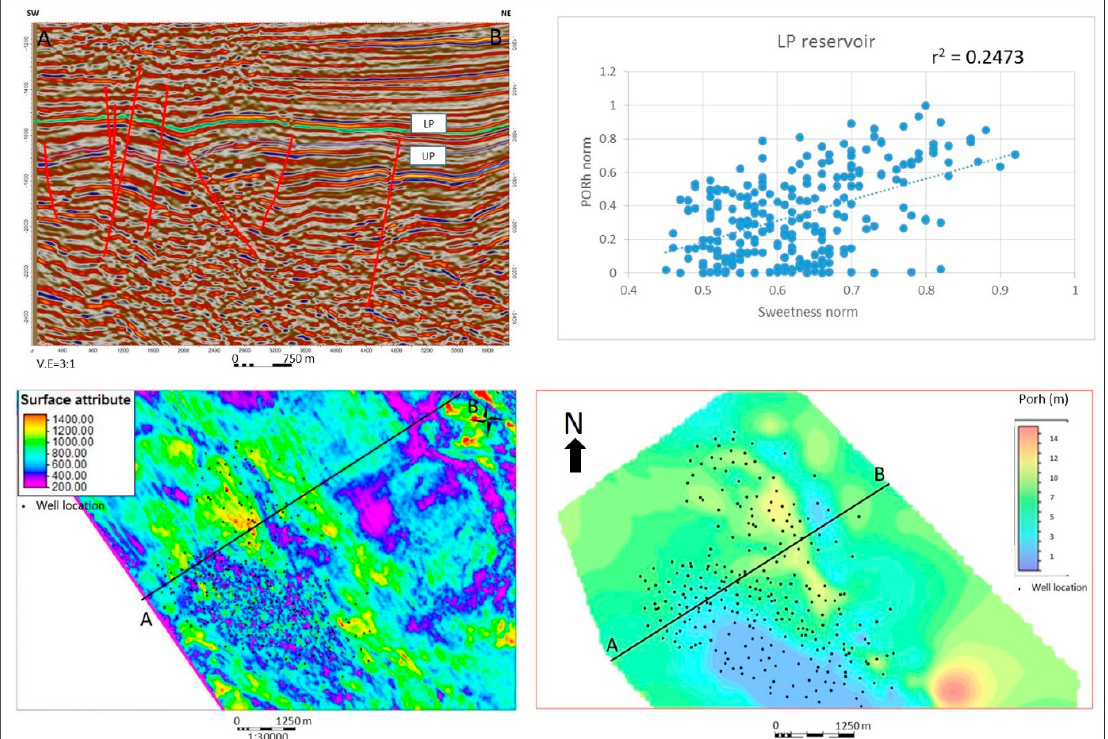
Figure 13. Correlation of the sweetness attribute and porosity–thickness map of the “LP” reservoir [29].